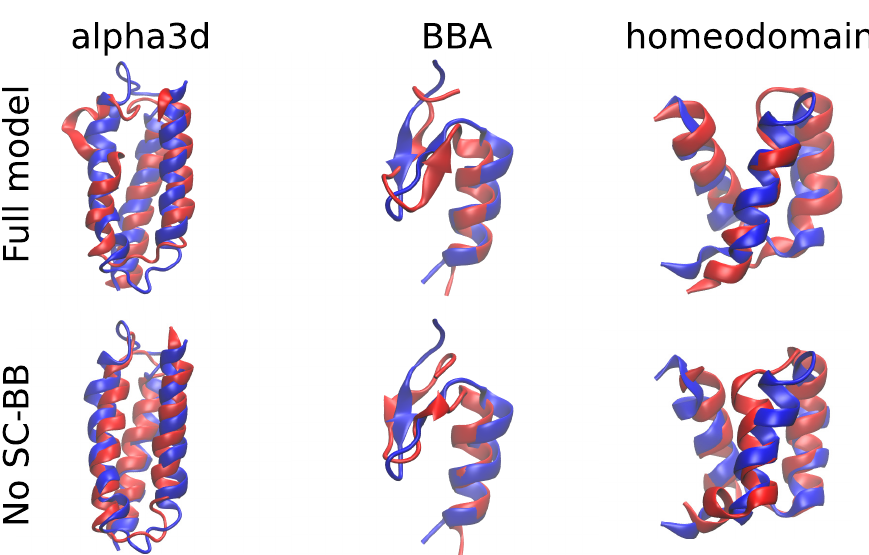
Fig 9. Closest structure to native protein (lowest C α -RMSD) at optimal hydrogen bonding strength, with and without backbone-side chain hydrogen bonds. For alpha3D, BBA and homeodomain with backbone-side chain hydrogen bonds, the optimal hydrogen bond strength and lowest C α -RMSD are -2.0, -2.0 and -1.9 RT, and 3.6, 1.7 and 3 Å , respectively. Without these hydrogen bonds, the corresponding values are -2.0, -1.8 and -1.6 RT; and 2.7, 1.8, and 2.5 Å . Blue is the native structure and red is the